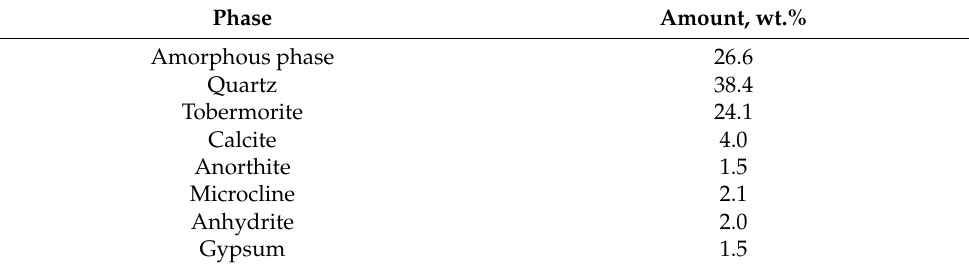
Table 2. Phase composition of autoclaved cellular concrete